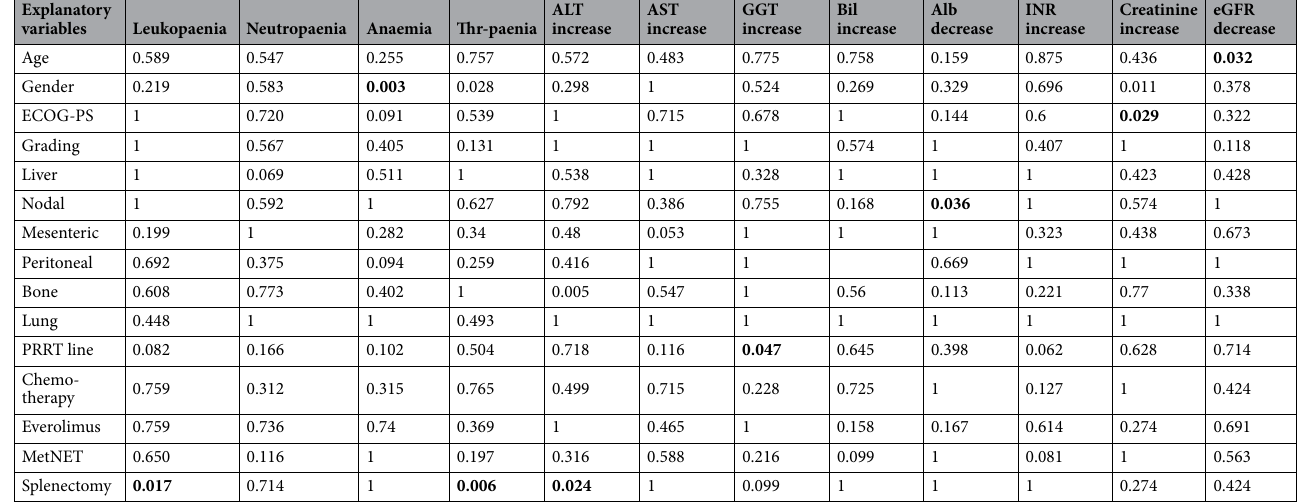
Table 3. P-values of Chi square/Fisher tests to evaluate the association between CTCAE and the independent variables; p-value of Wilcoxon’s test for variable Age. bold values indicate statistical significance, in accordance with the conventionallyaccepted threshold (< 0.05). Thr-paenia: